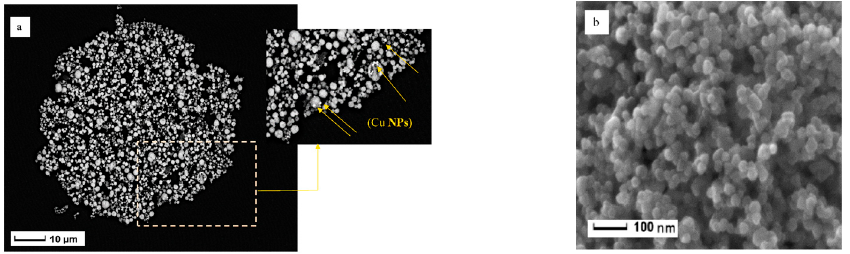
Figure 11. ( a ) FE ‐ SEM image of a ZnO on Cu NPs. ( b ) High ‐ resolution image of aggregated ZnO Figure 11. ( a ) FE-SEM image of a ZnO on Cu NPs. ( b ) High-resolution image of aggregated ZnO [111]. [111]. The resulting material was used in an amperometric glucose sensor and showed a high reaction and